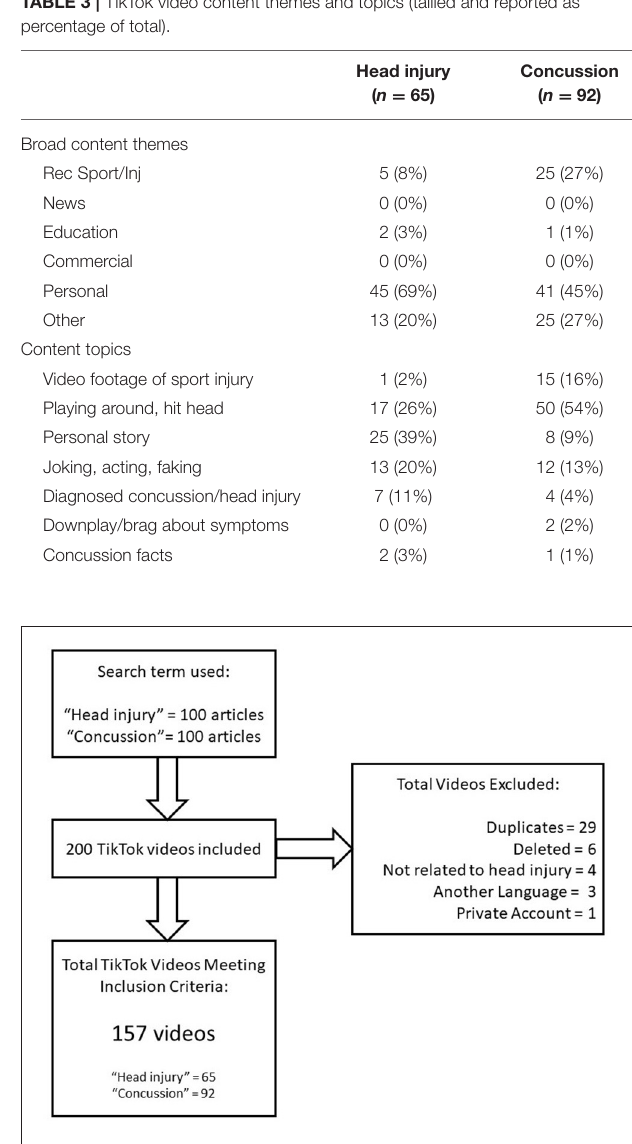
FIGURE 1 | Flowchart showing how videos were